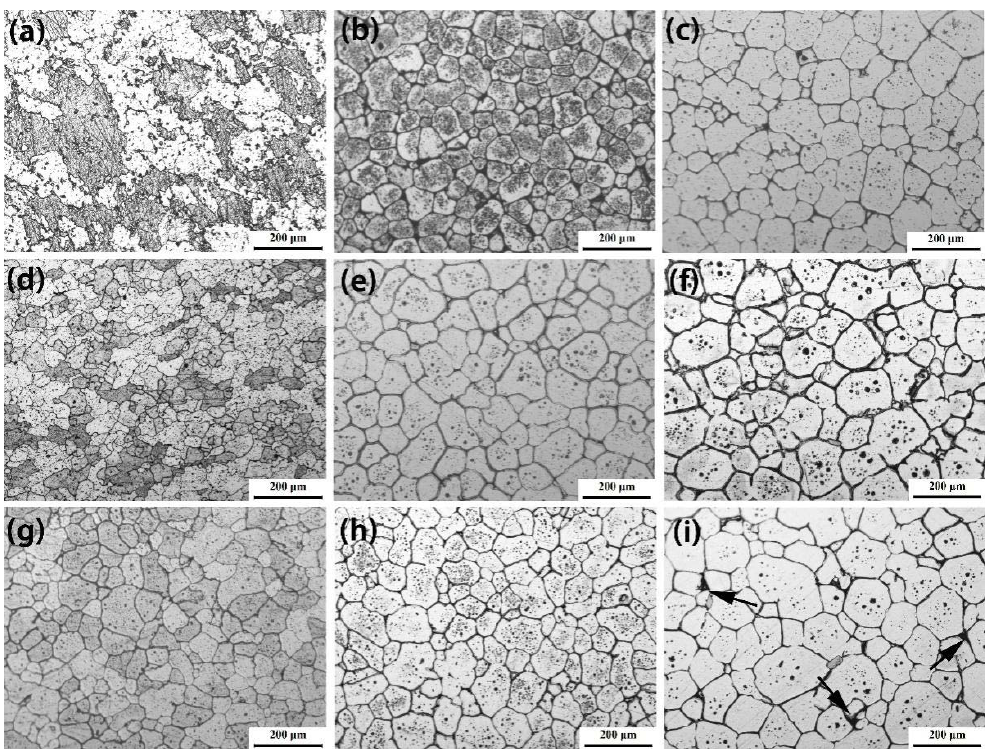
Figure 2. The OM images of the recrystallization and partial remelting (RAP) ‐ processed AA7075 alloy held at 600–620 °C for 5–25 min, ( a ) 600 °C ‐ 5 min; ( b ) 600 °C ‐ 15 min; ( c ) 600 °C ‐ 25 min; ( d ) 610 °C ‐ 5 min; ( e ) 610 °C ‐ 15 min; ( f ) 610 °C ‐ 25 min; ( g ) 620 °C ‐ 5 min; ( h ) 620 °C ‐ 15 min; ( i ) 620 °C ‐ 25 min.